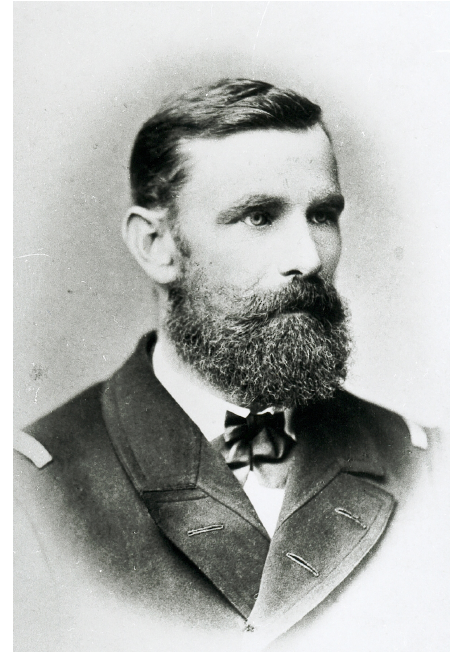
Figure 1. Karl Weyprecht (1838–1881) – Austrian geophysicist (https://en.wikipedia.org/wiki/Karl_Weyprecht, last access: 11 Au- gust 2020).